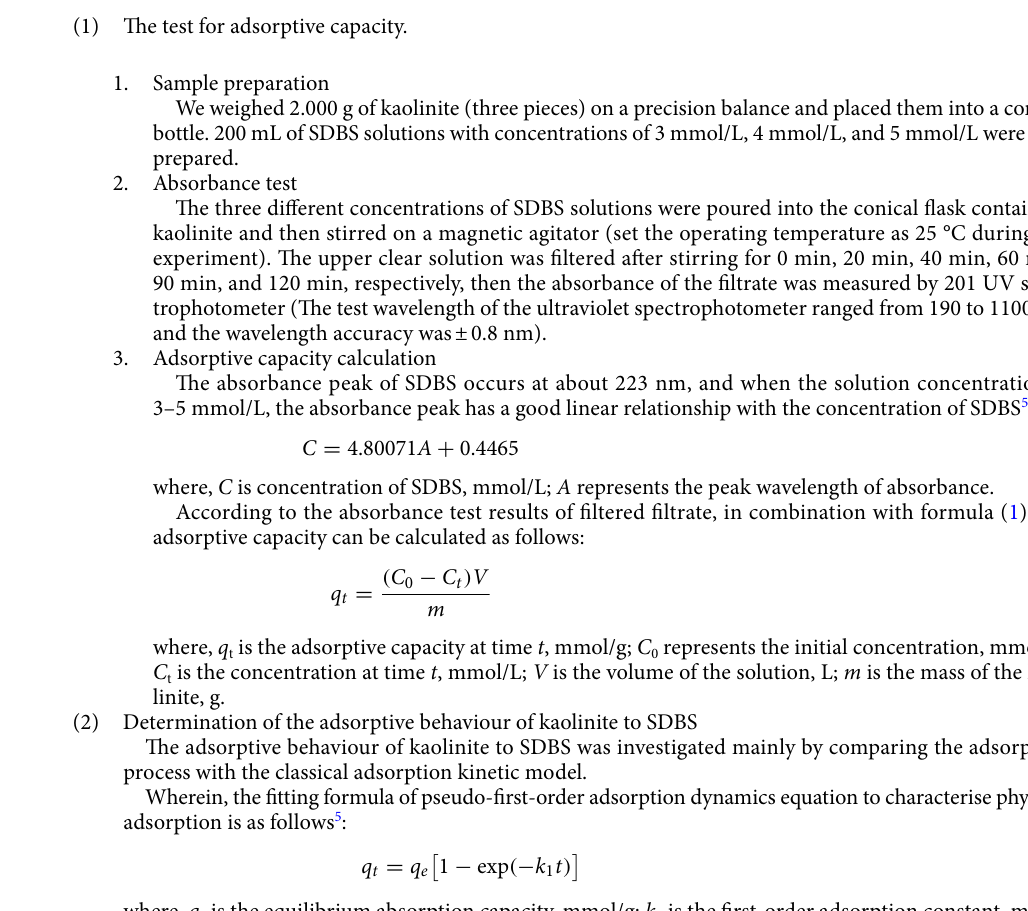
model, pseudo-second-order adsorption kinetic model, Elovich kinetic model, and Bangham adsorption rate model 10–15 . It is generally believed that pseudo-first-order adsorption kinetics model is more accurate for the adsorption process fitting of physical adsorption, while the pseudo-second-order adsorption kinetics model is more accurate when simulating chemical adsorption 16–18 . The structural change characteristics of minerals after adsorption of anionic surfactant were mainly detected by scanning electron microscopy with energy dispersive spectrometry (SEM–EDS), X-ray diffraction (XRD), and infrared spectroscopy (FTIR) 19–24 . Herein, the adsorptive capacity of kaolinite to SDBS at different concentrations under different time was tested with the help of ultraviolet spectrophotometry, and the adsorption type of SDBS was determined by fitting the adsorption process with the classical model. SEM–EDS, XRD, and FTIR were used to test the differences in element content, layer spacing, and main functional groups before and after adsorption. The structural changes of kaolinite were thus obtained. The research can provide a basis for selecting the best concentration of SDBS. Experimental samples The main samples required for the experiment were the anionic surfactant SDBS and kaolinite minerals. The SDBS (analytically pure) used in the experiment was produced by Fangzheng Reagent Factory, Beichen District, Tianjin, China. In the SDBS (C 18 H 29 NaO 3 S), the active substance content is ≥ 90%, the sodium salt content is ≤ 7%, and the moisture content is ≤ 3%. The block sample had good crystallinity and few impurities (the kaolinite con- tent is greater than 95%). The kaolinite sample was pulverised and then tested by X-ray diffraction and energy spectral analysis. The chemical formula of the kaolinite powder was Al 2 Si 2 O 5 (OH) 4 . The oxidic composition and mass fraction of each mineral in kaolinite are shown in Table 1.